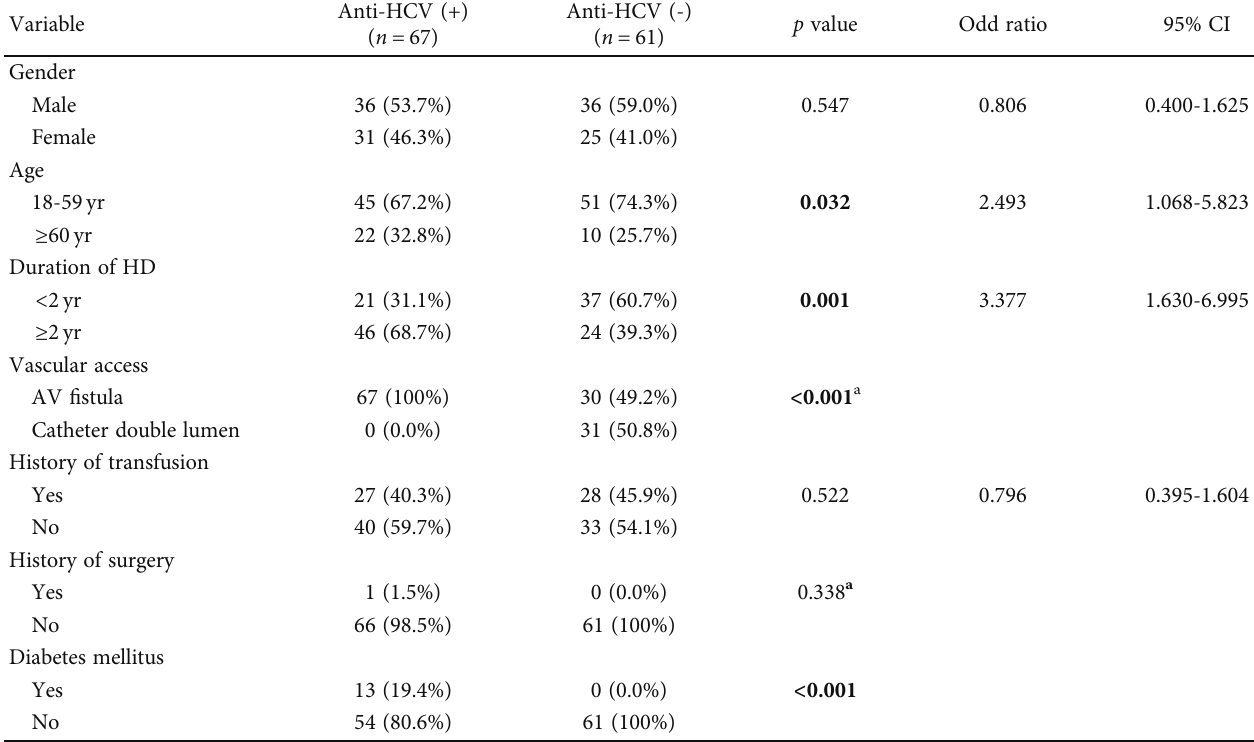
Table 4: Association of risk factors with HCV infection in hemodialysis patients (private unit).